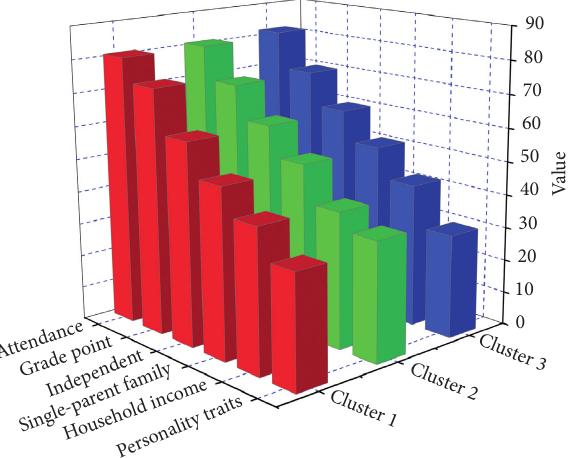
Figure 4: Initial cluster